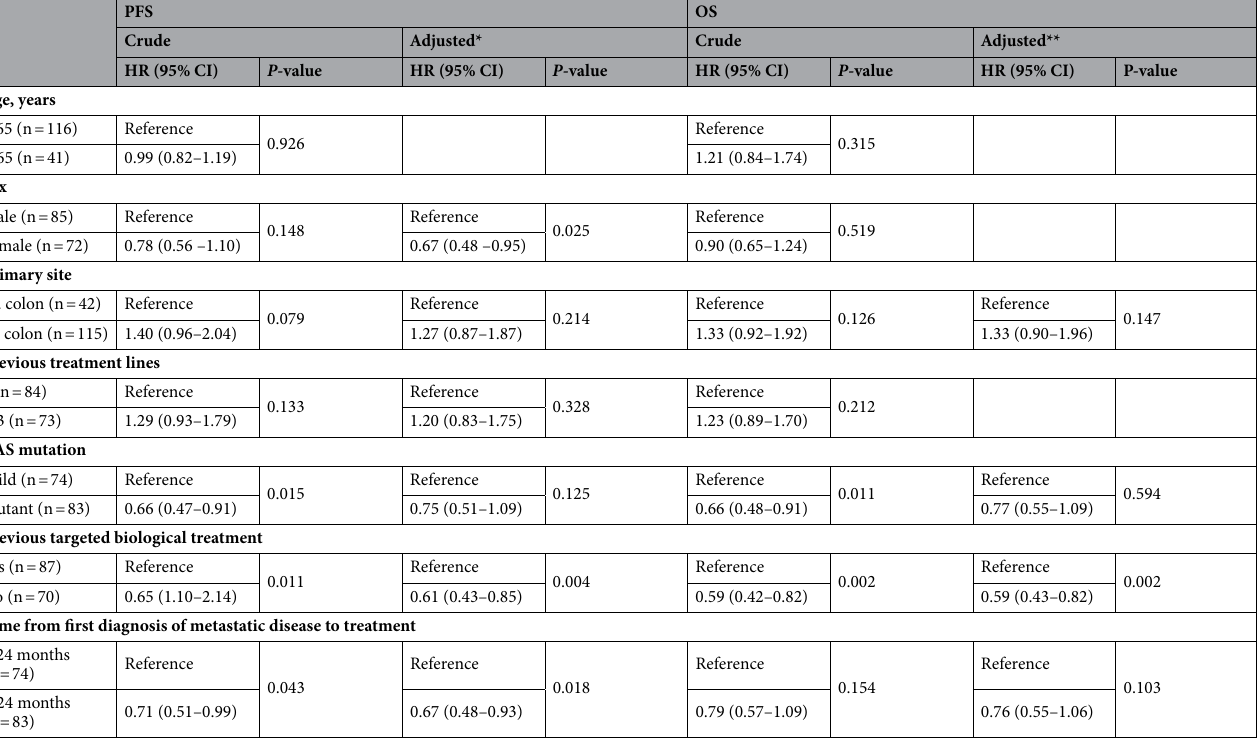
Table 3. Multivariable analysis using the Cox regression model for survival outcomes. *Adjusted for sex, primary site, prior chemotherapy lines, RAS mutation, prior history of targeted agents, and time from